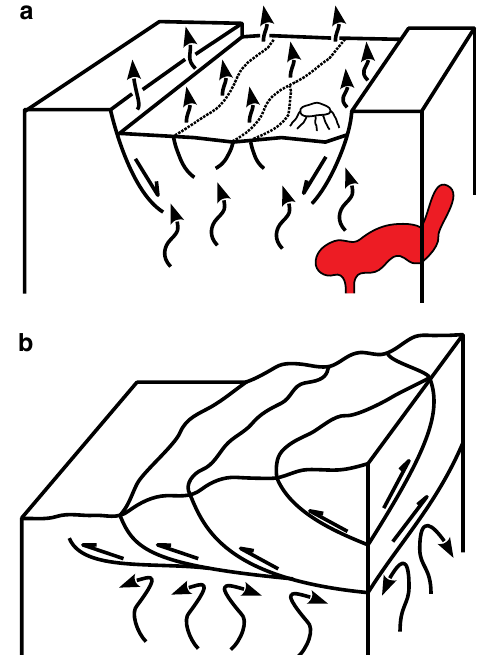
Fig. 1 Earth degassing and tectonic regimes. a Sketch of an extensional tectonic setting with the pathways of fl uids rising through the fractures. b Compressional tectonic setting with overlapping structures that may inhibit the rise of deep fl